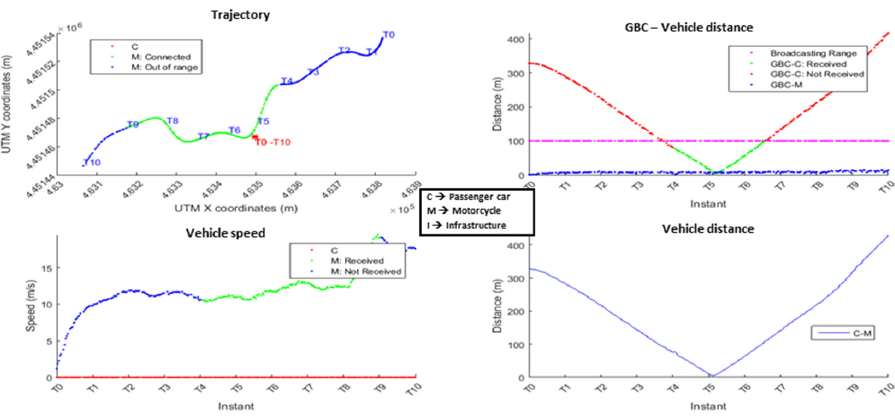
Figure 6. Results of Test 2 without RSU.